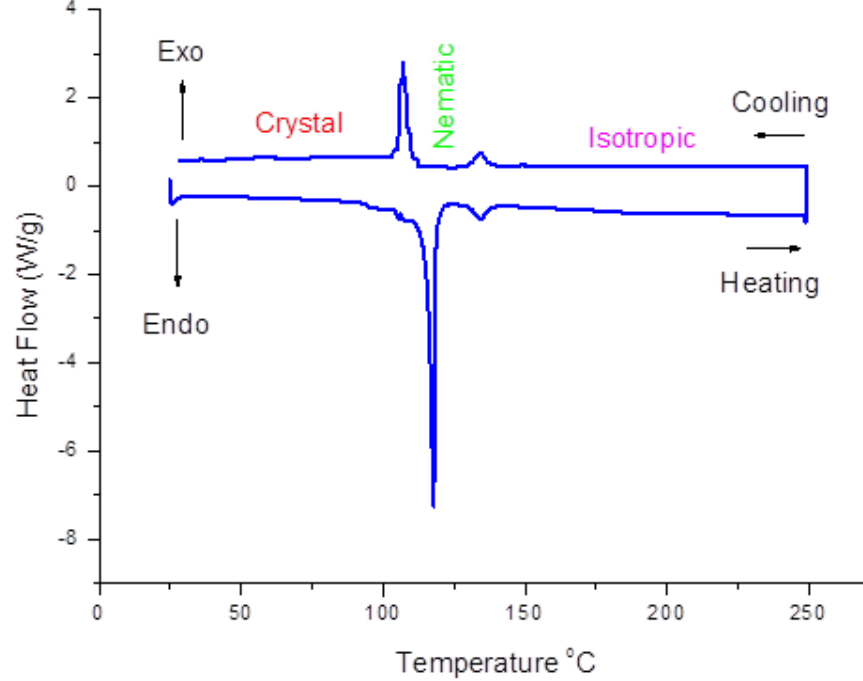
Figure 2. Differential scanning calorimetry (DSC) thermogram of compound A during heating and cooling cycles, at 10.0 °C/min.